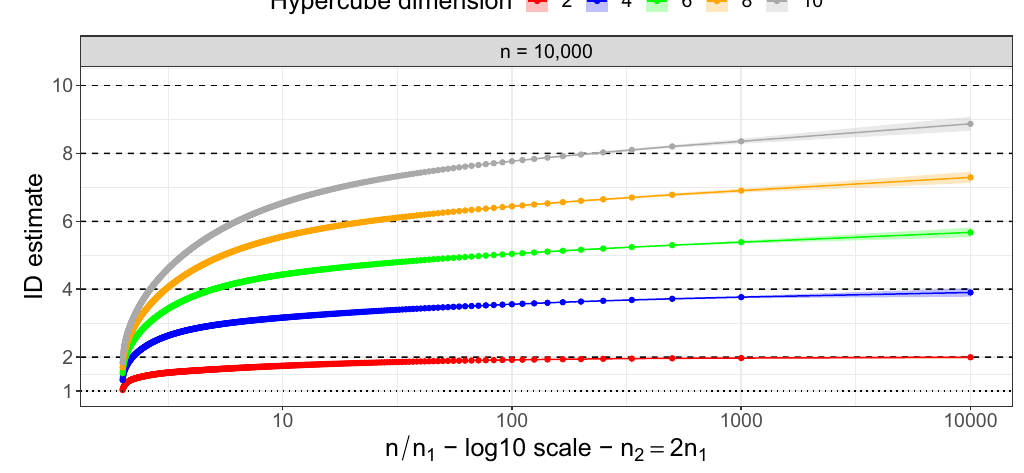
Figure 4. Evolution of the id estimates as a function of the ratio n / n 1 (logarithmic scale) computed on uniform hypercubes characterized by different sample sizes and increasing true id . Gride is computed setting 2 n 1 . The horizontal lines highlight the true values of the n 2 =